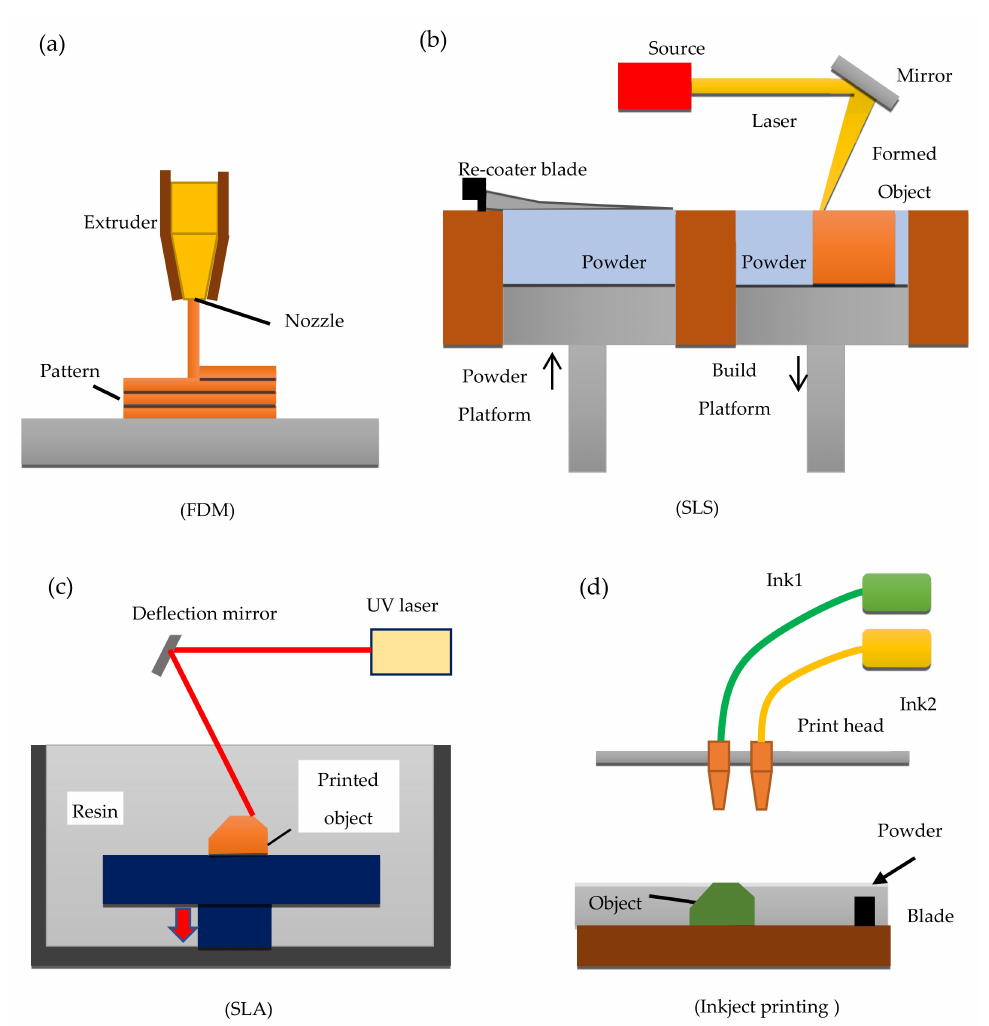
Figure 1. Schematic diagram of ( a ) FDM; ( b ) SLS; ( c ) SLA; ( d ) and inkjet